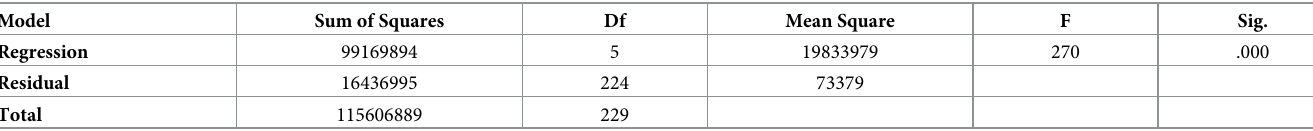
Table 11. ANOVA test of the linear regression model.